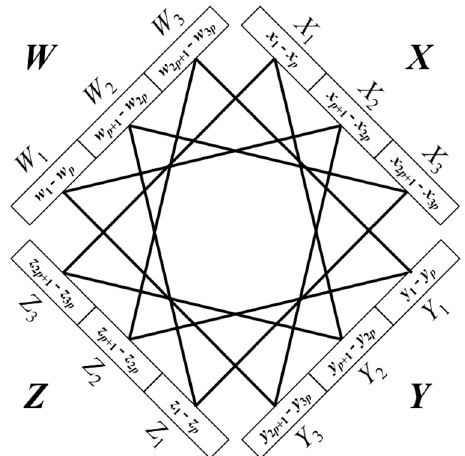
Figure 1. An illustration of the construction used in the k = 4 case of Theorem 2. Lines denote bundles of edges that are absent from a balanced complete 4-partite graph of order n .